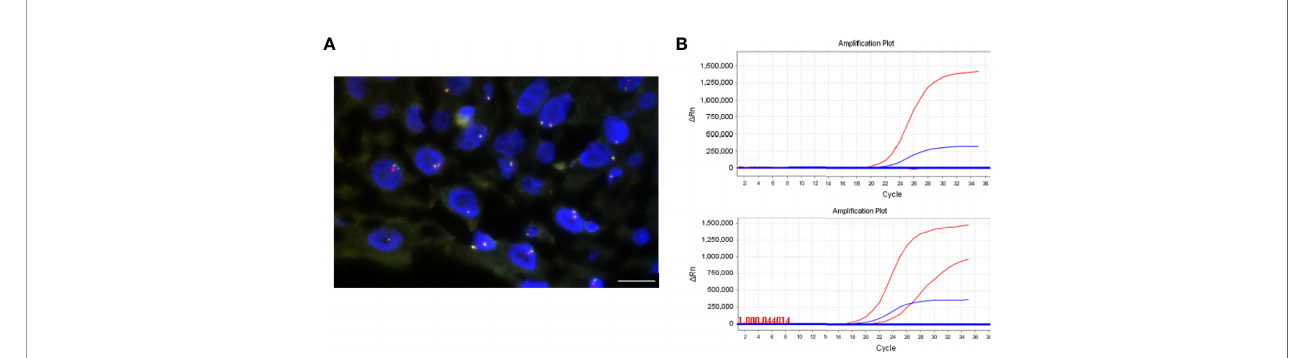
FIGURE 4 | NTRK1 rearrangements and BRAF V600E mutation detection. (A) FISH assay using split FISH probes for con fi rming NTRK1 rearrangements. No split red and green signals were observed. (B) BRAF V600E mutation was detected by real-time PCR. The top is negative, and bottom is positive. The scale bar = 20